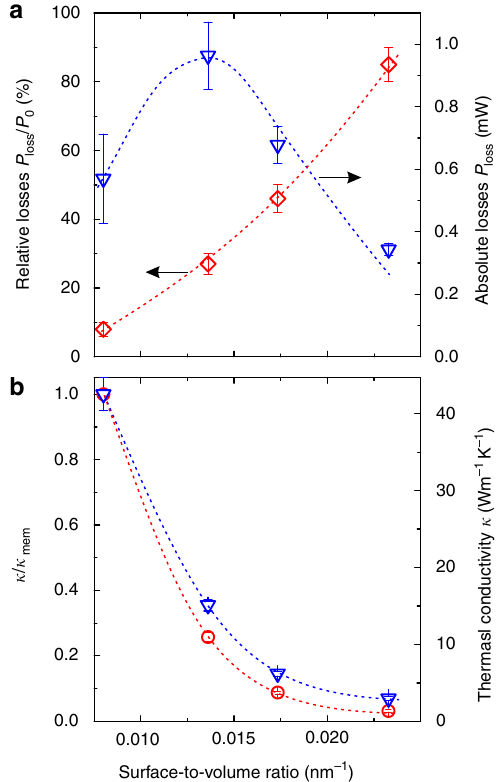
Fig. 5 Air-mediated heat losses. a Relative ( red diamonds , left axis ) and absolute ( blue triangles , right axis ) losses caused by air-mediated cooling as a function of surface-to-volume ratio. b Measured κ exp = κε ( red circles ) and intrinsic κ ( blue triangles ) thermal conductivity at 600 K as a function of surface-to-volume ratio. The dashed lines in a , b are guides to the eye. The errors bars are derived using the error propagation of κ derived in Methods